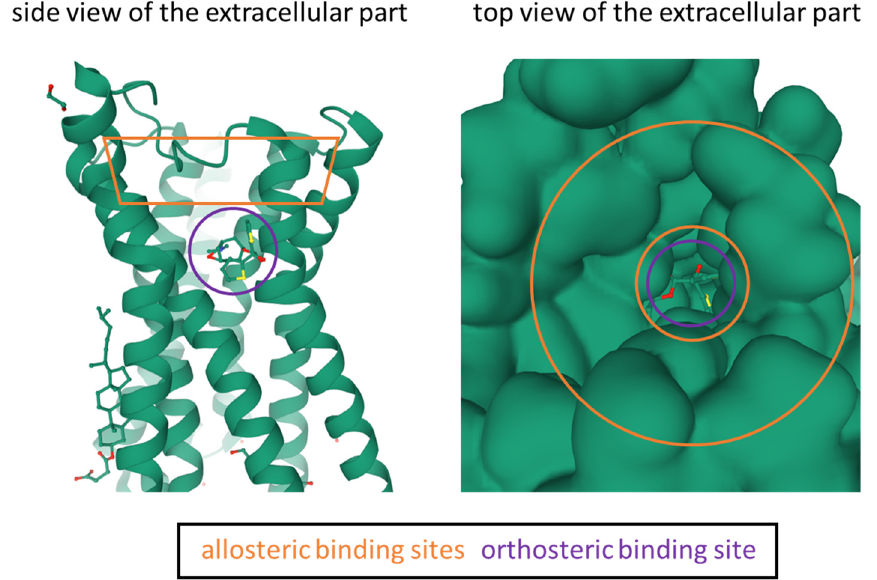
Figure 1. Graphical illustration of the mAChR M1 crystal structure PDB:5CXV [54] using Mol* [62]. The approximal location of the orthosteric binding site and the allosteric binding sites are highlighted. The receptor structure contains the co-crystallized orthosteric antagonist tiotropium, which is displayed in ‘ball and stick’ style. In the side view the protein is displayed as cartoon and in the top view it is displayed as Gaussian surface.